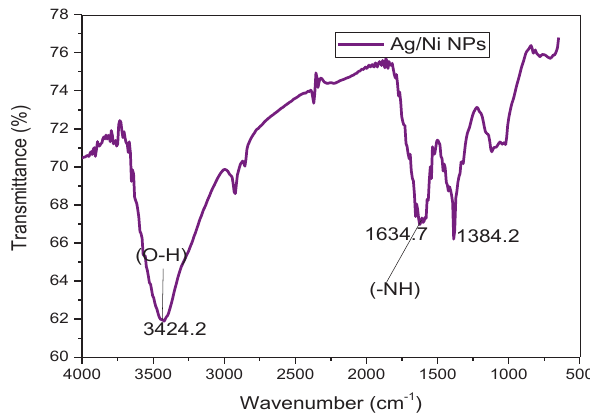
Figure 3: FT IR spectrum of silver/nickel bi-metallic nanoparticles using Z. root